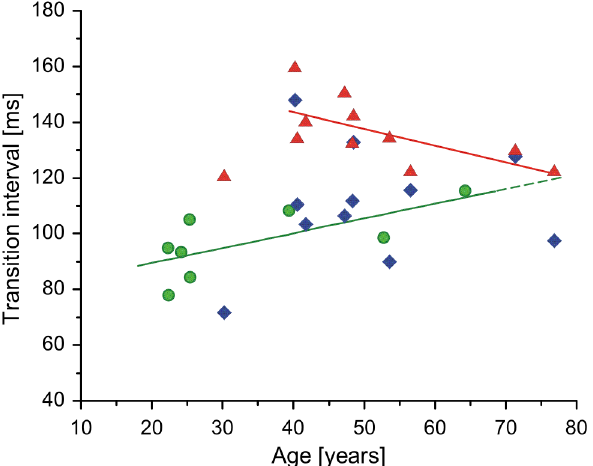
Fig 2. Relationship between mean values of TI, calculated for each subject from single MU data, and subject’s age: Circles, control subjects; triangles, patient’s more-affected muscles; diamonds, patient’s less-affected muscles. Note that data for older patients are close to the control regression line. Note also an outlier for the youngest patient, who had the stroke 12 years before the experiment.